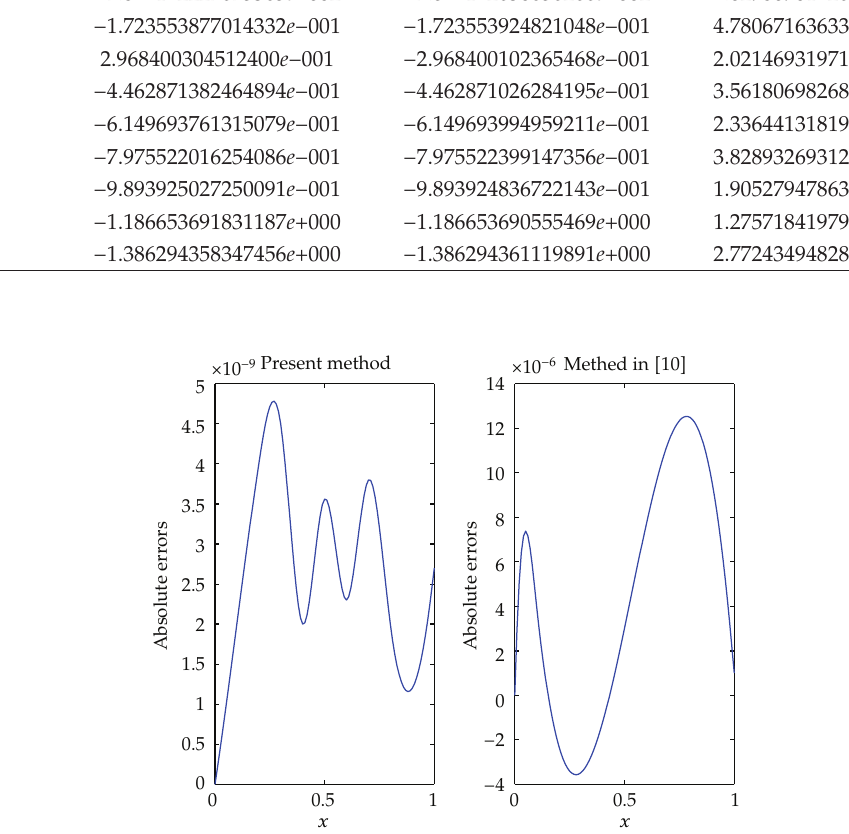
Figure 1: Comparison of absolute errors using the present method and method in (cid:7) 10 (cid:8) for Example